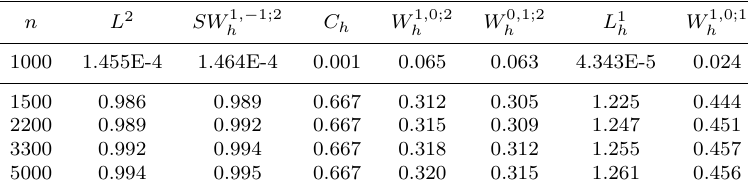
Table 11. Practical errors and error orders in Example B 1 /